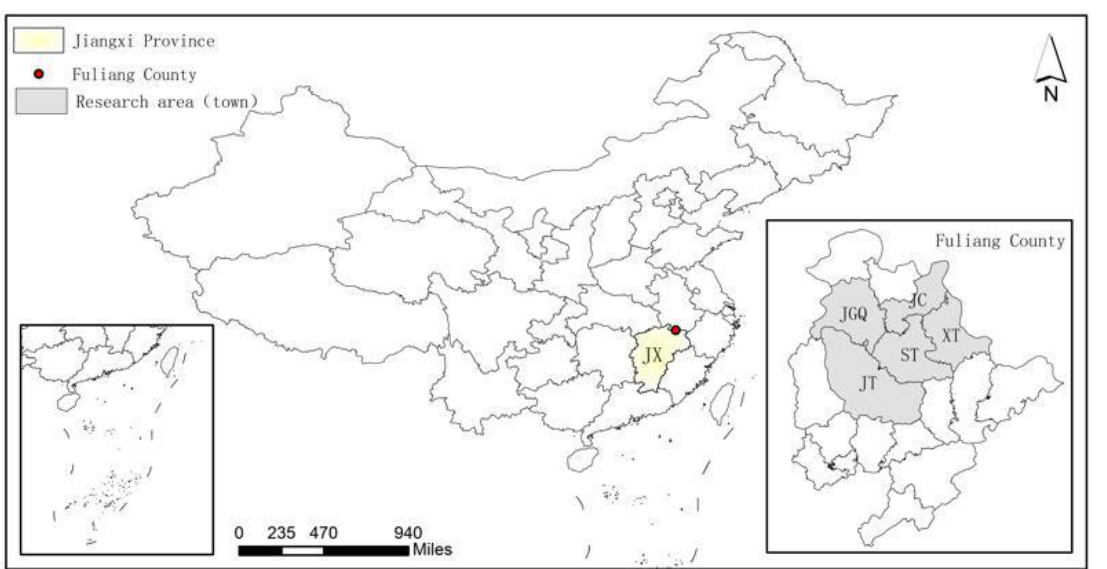
Table 2. Sample location